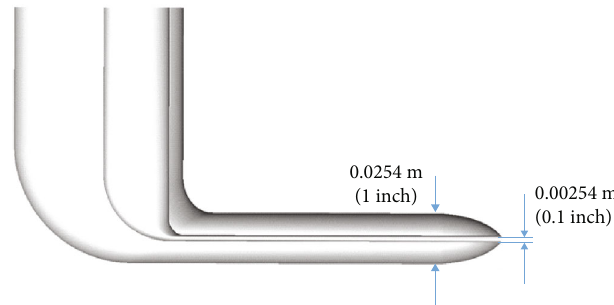
Figure 9: Simpli fi ed pitot-static tube con fi gurations considered in this study.